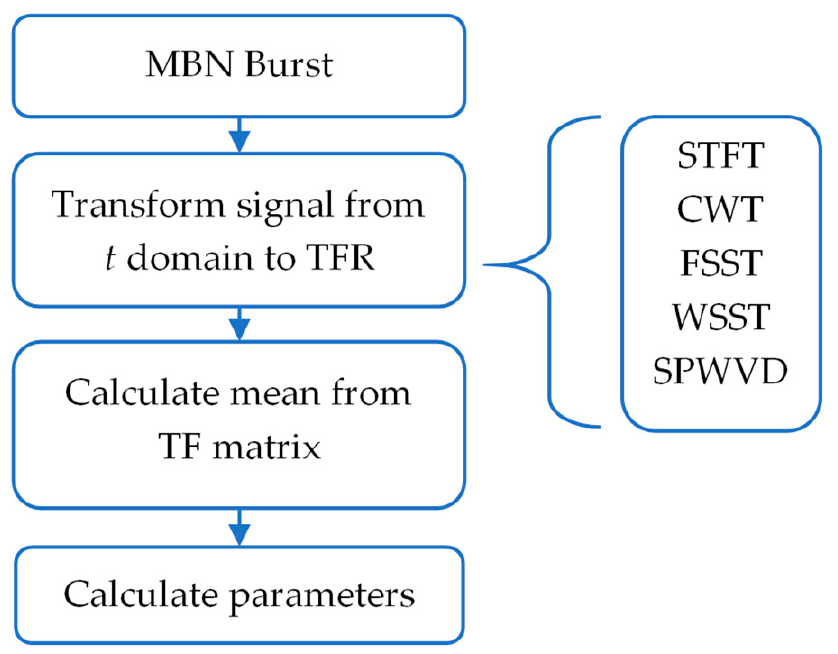
Figure 3 . Calculation procedure